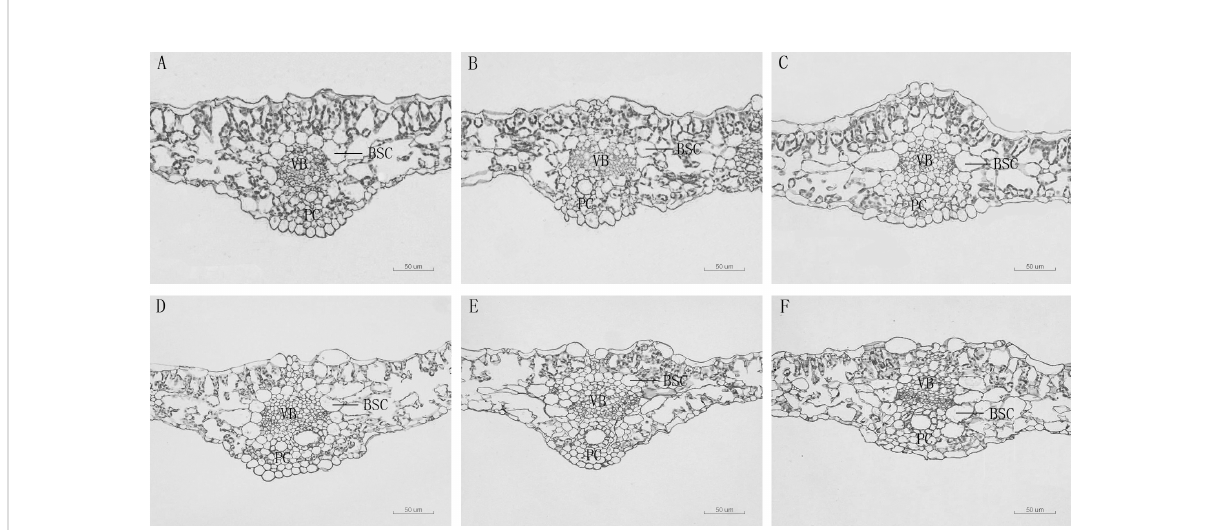
FIGURE 3 Leaf vein transverse anatomical structure of leaf blade of D. carota under Mn treatments (A – F) . BSC: bundle sheath cells, V, vascular bundle, C, pachycorn cells. (A) CK, (B) 1,000 µM, (C) 5,000 µM, (D) 10,000 µM, (E) 15,000 µM, (F) 20,000 µM.